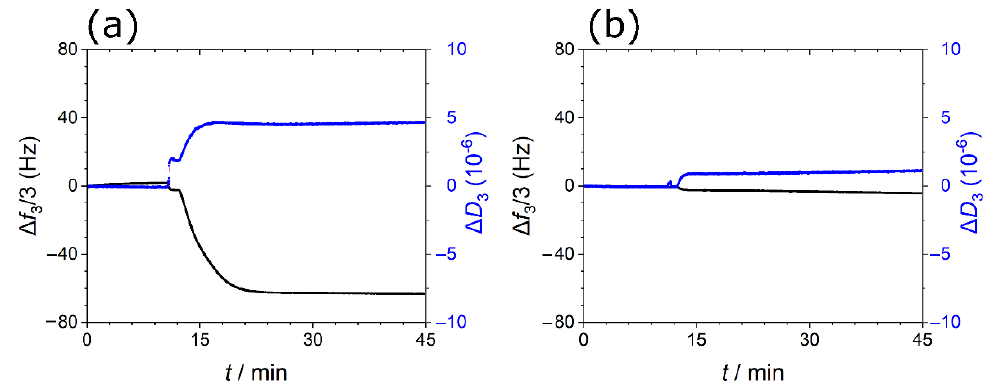
Figure 7. QCM-D graphs of the sample composed of DSPC:DPSE-PEG2000 with molar fractions of 75:25 applied to a silica sensor equilibrated with ( a ) 10 mM HEPES buffer with 150 mM NaCl or ( b ) with 10 mM HEPES buffer with 75 mM CaCl2. Samples were measured at 25 °C.